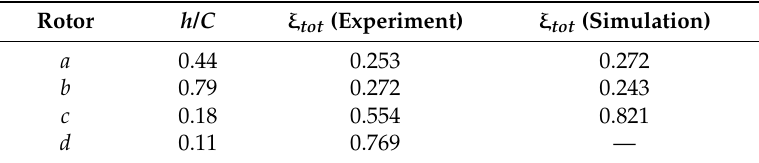
Table 2. Ohlsson [37] rotors simulated and measured loss